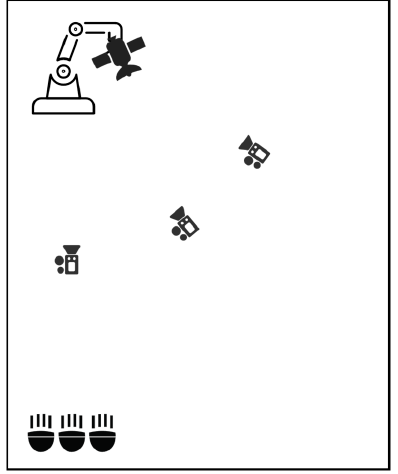
Figure 7. Environmental simulation equipment: ( a ) solar simulator; ( b ) robot arm. The color temperature of the solar simulator is 6000 K, and the wavelength range is 400–800 nm. We installed the model on the robot arm and obtained space objects images at different positions and attitudes and lighting angles by rotating the manipulator. The layout of solar simulator and robot arm is shown in Figure 8.